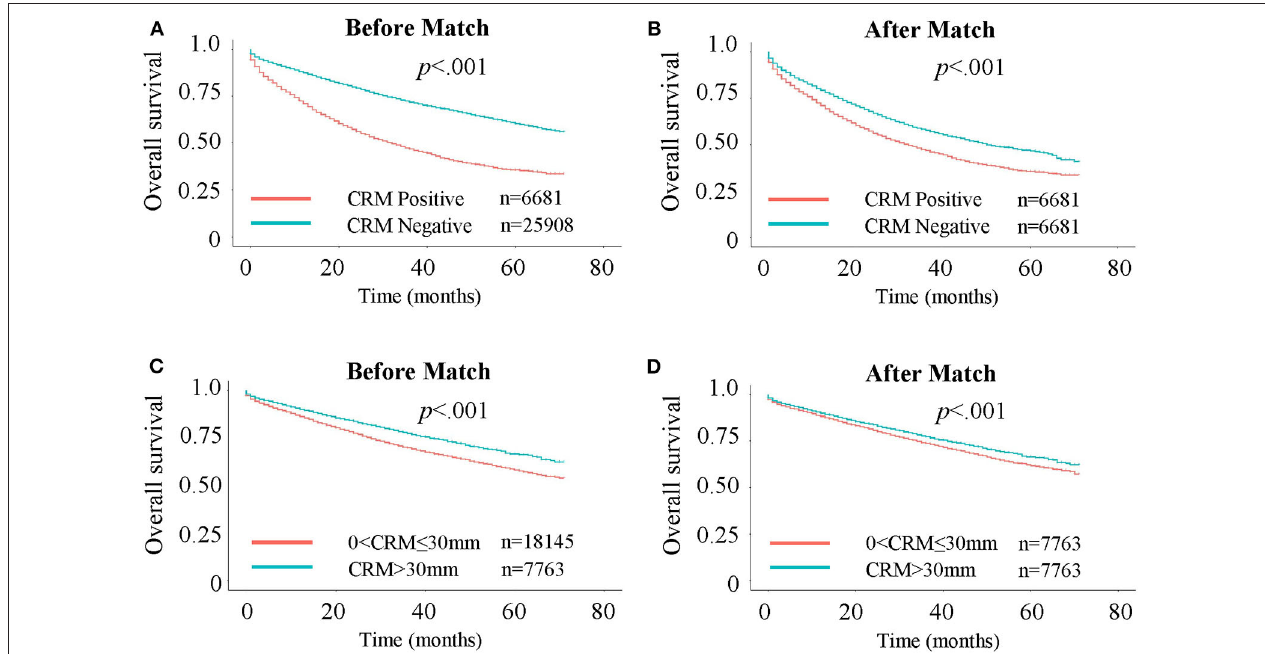
FIGURE 1 | Kaplan-Meier curves for Overall Survival (OS). (A) OS in CRM-positive/negative patients. (B) OS in CRM-positive/negative patients after 1:1 propensity score matching. (C) OS in patients with CRM values of 0–30 and > 30mm. (D) OS in patients with CRM values of 0–30 and > 30mm after 1:1 propensity score